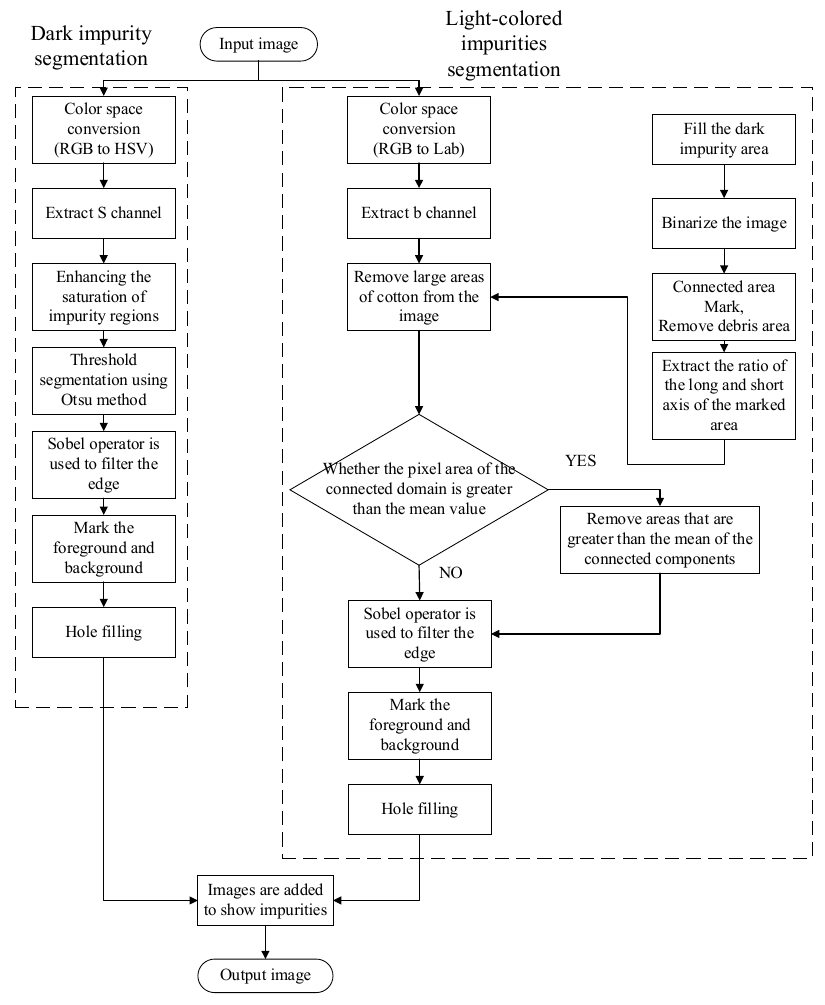
Figure 2. Multi-channel fusion segmentation process of impurity images of machine-picked seed cotton.